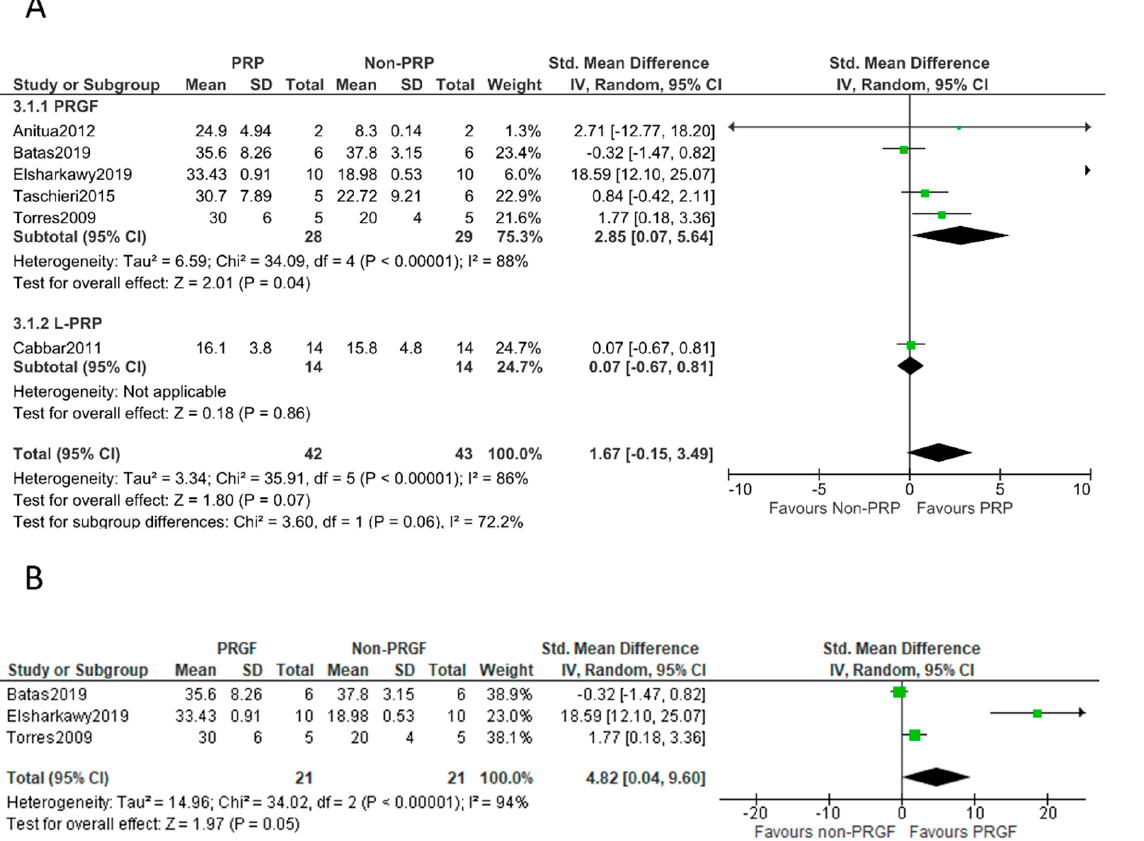
Figure 4. Meta-analysis of the studies evaluating new bone formation. ( A ) Randomized clinical trials and controlled clinical trials. ( B ) Only randomized clinical trials. SE: standard error. SMD: standardized mean difference. CI: confidence interval [35,36,38,40,47].